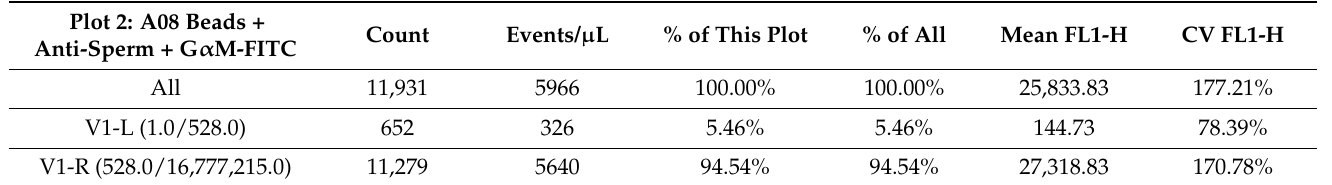
Figure 7. Physical characteristics of magnetic bead on monoclonal antibody 1F9 showing the relationship between the correlation between the Fluorescent Light Intensity (FL1-H) and the number of cells (Count) in the histogram ( a ) The magnetic bead on monoclonal antibody 1F9 ( b ) the Magnetic Bead on Monoclonal Antibody 1F9 stained with G α M-FITC. Table 3. Physical Characteristics of Magnetic Particle Beads on Monoclonal Antibody Stained with G α M-FITC (Plot 2).